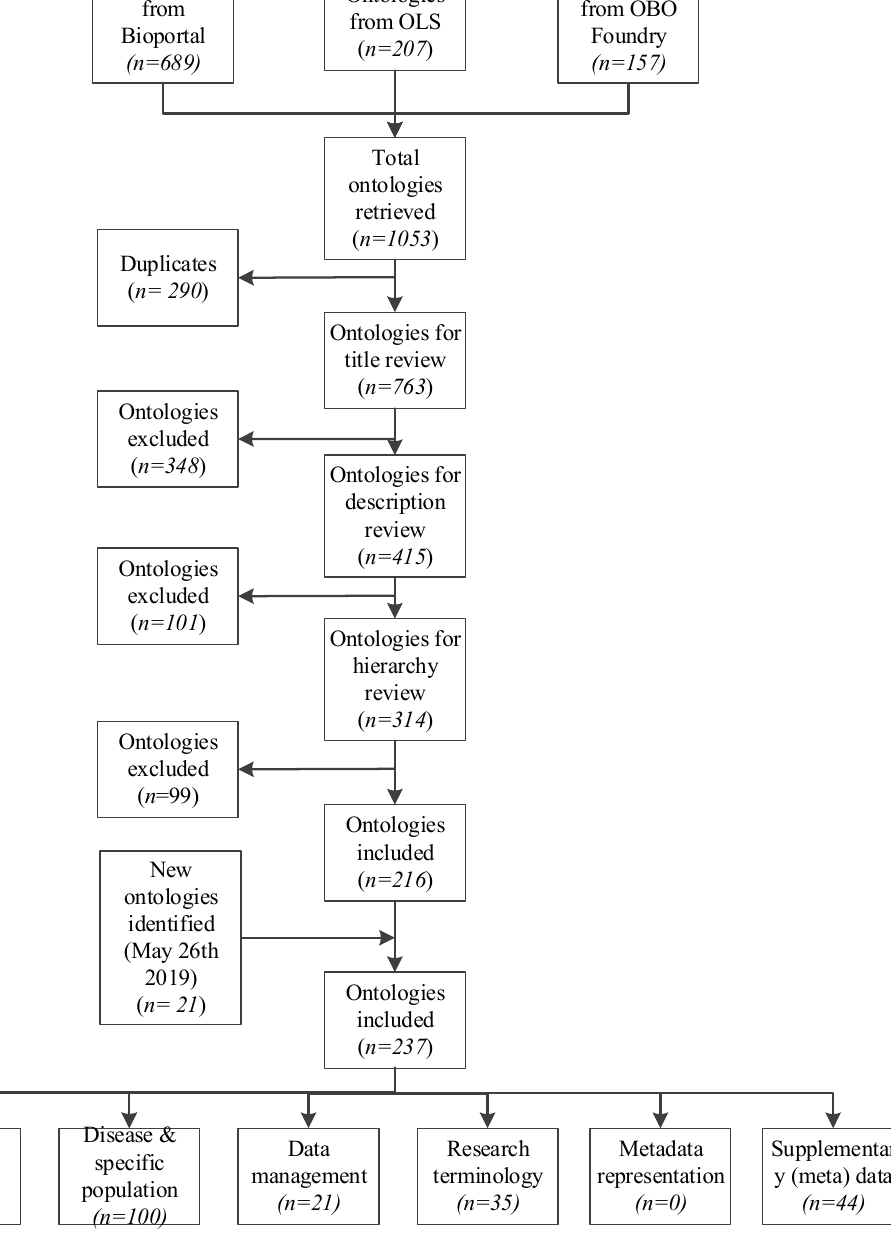
Figure 1. Review and selection process of ontologies for nutritional epidemiology.